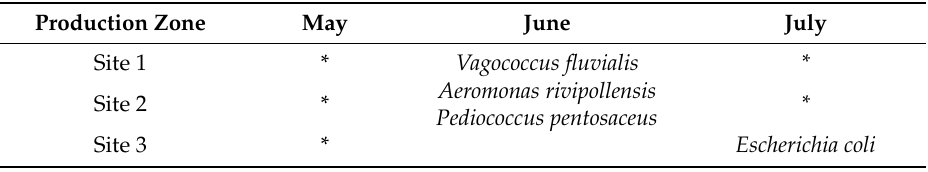
Table 6. Isolates of ciprofloxacin-resistant bacteria identified.